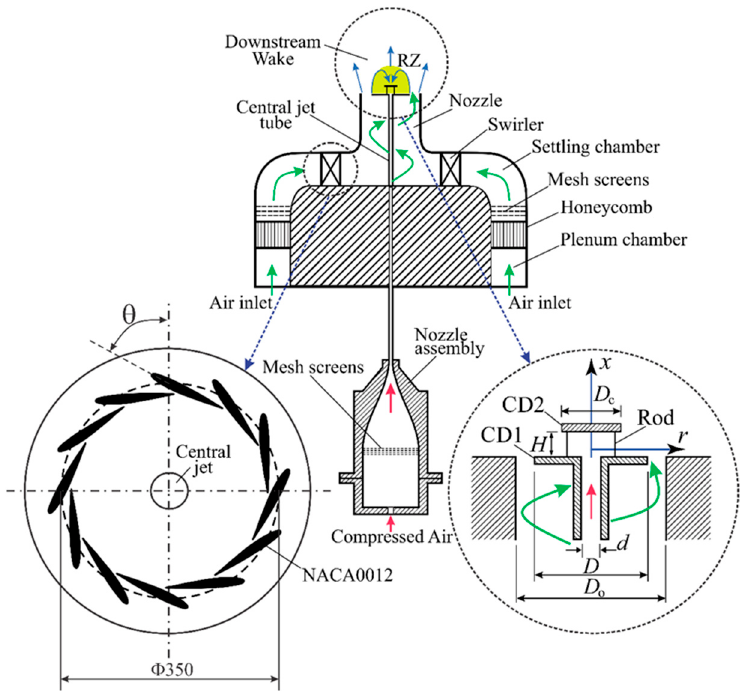
Figure 1. Schematic of the experimental setup.